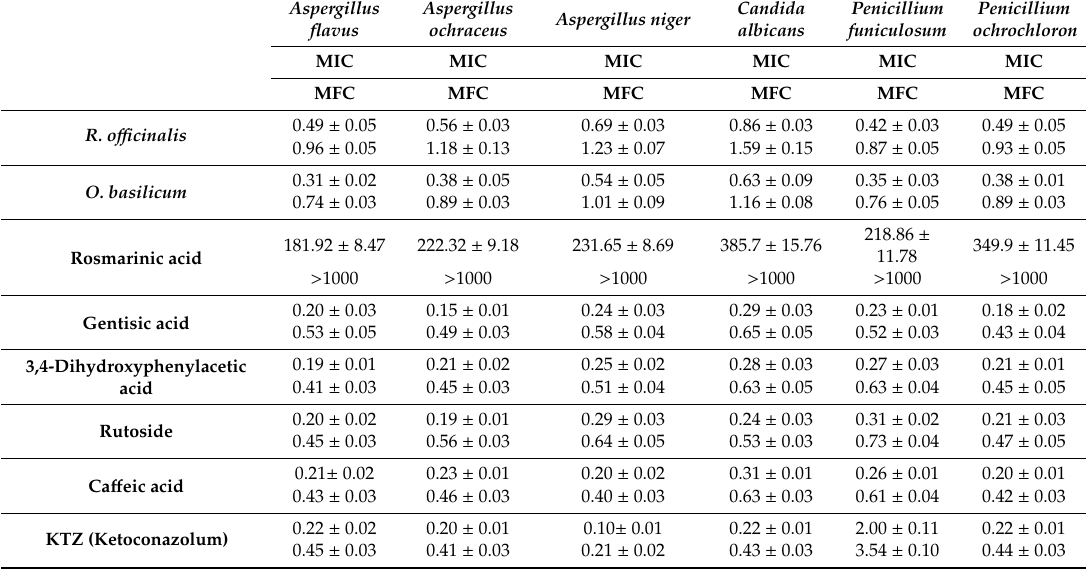
Table 5. Minimum inhibitory (MIC) and fungicidal concentration (MFC) of R. o ffi cinalis and O. basilicum leaf extracts, rosmarinic acid, 3,4-dihydroxyphenylacetic acid, gentisic acid and rutoside. Values are means of 3 replicates in (mg mL − 1 ). Candida Aspergillus Aspergillus Aspergillus niger flavus ochraceus